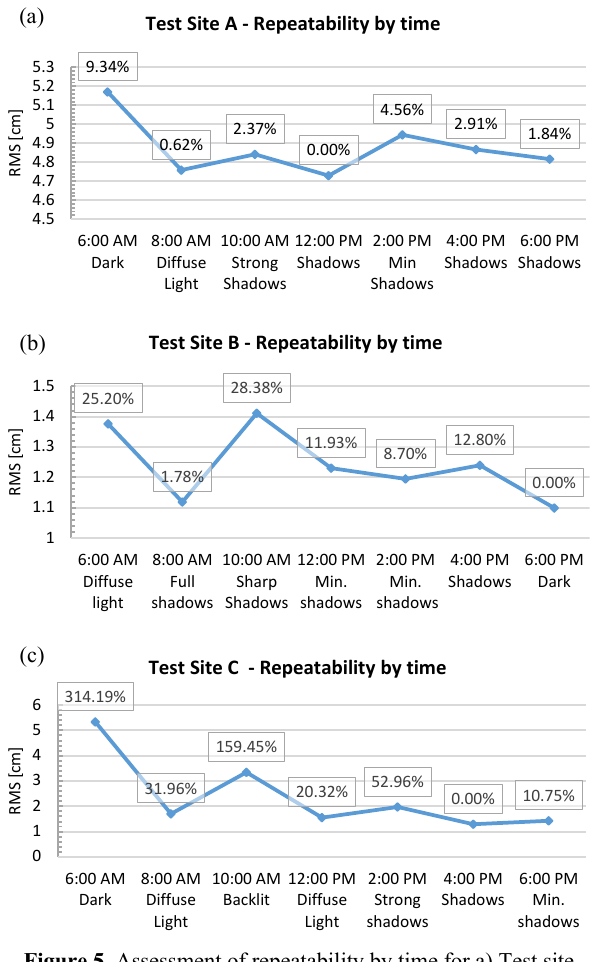
Figure 5. Assessment of repeatability by time for a) Test site A, b) Test site B and c) Test site C. The graph labels show the RMS % increase w.r.t. best